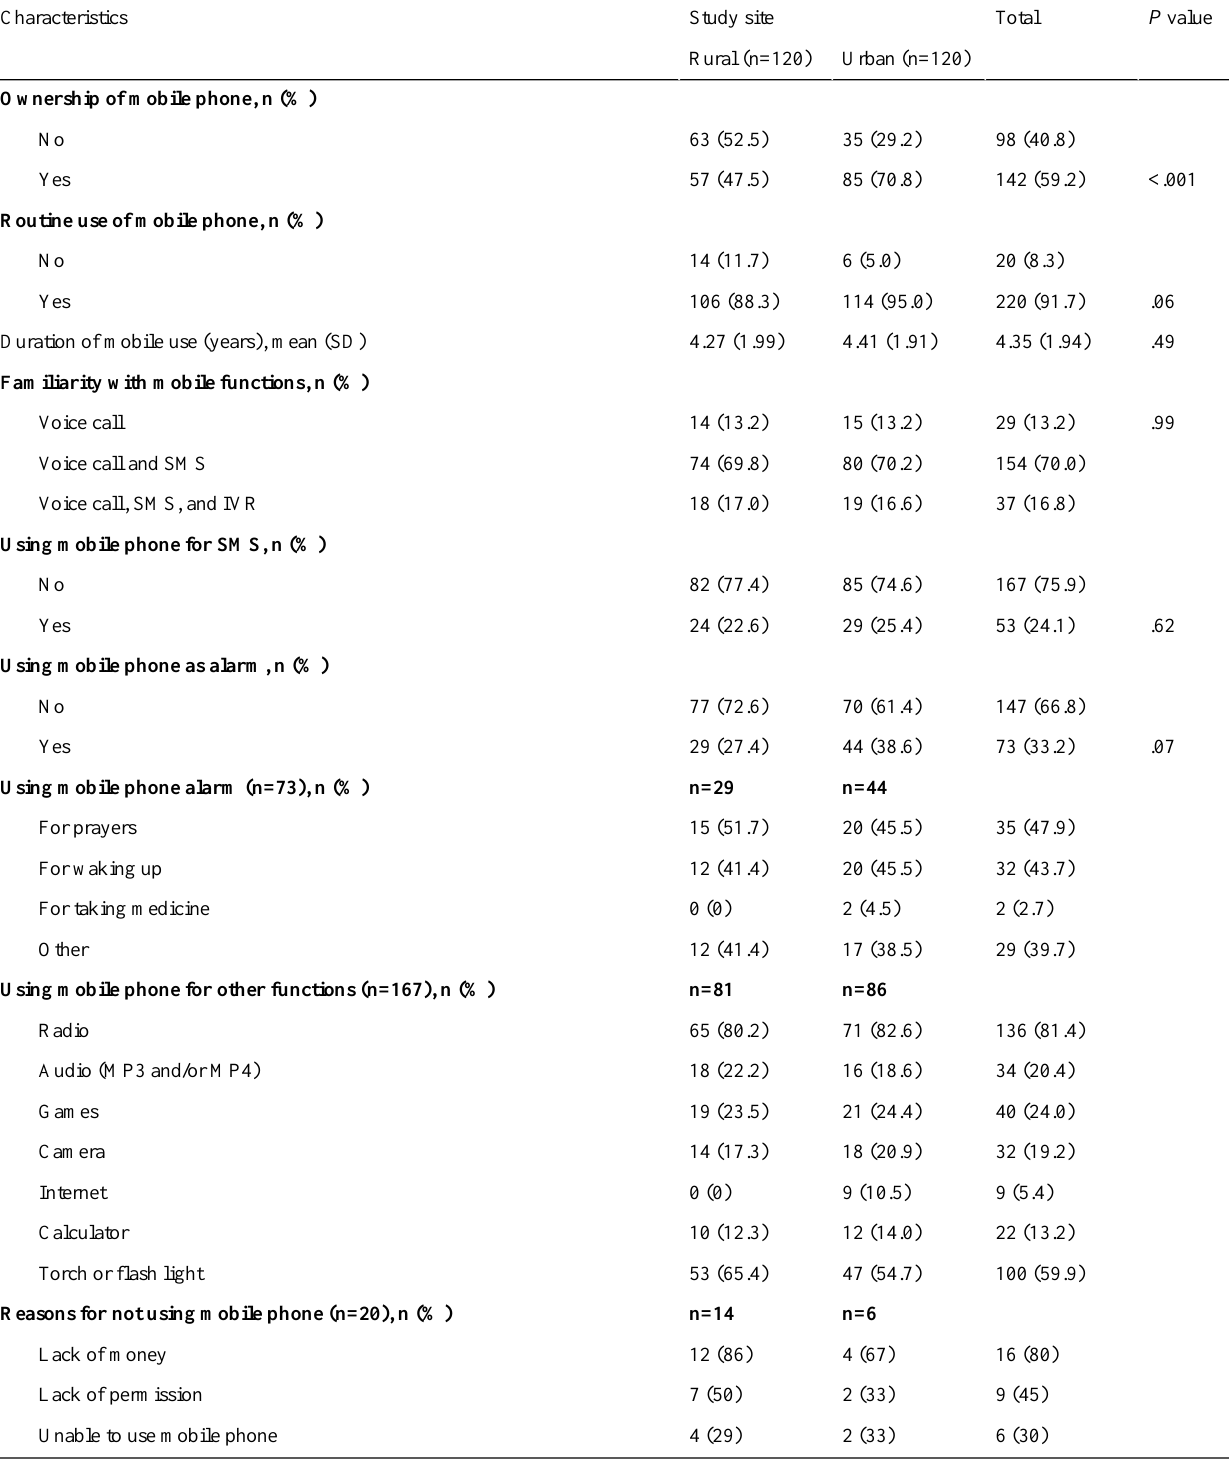
Table 2. Characteristics of mobile phone use (N=240). IVR: interactive voice response. SMS: short message service.